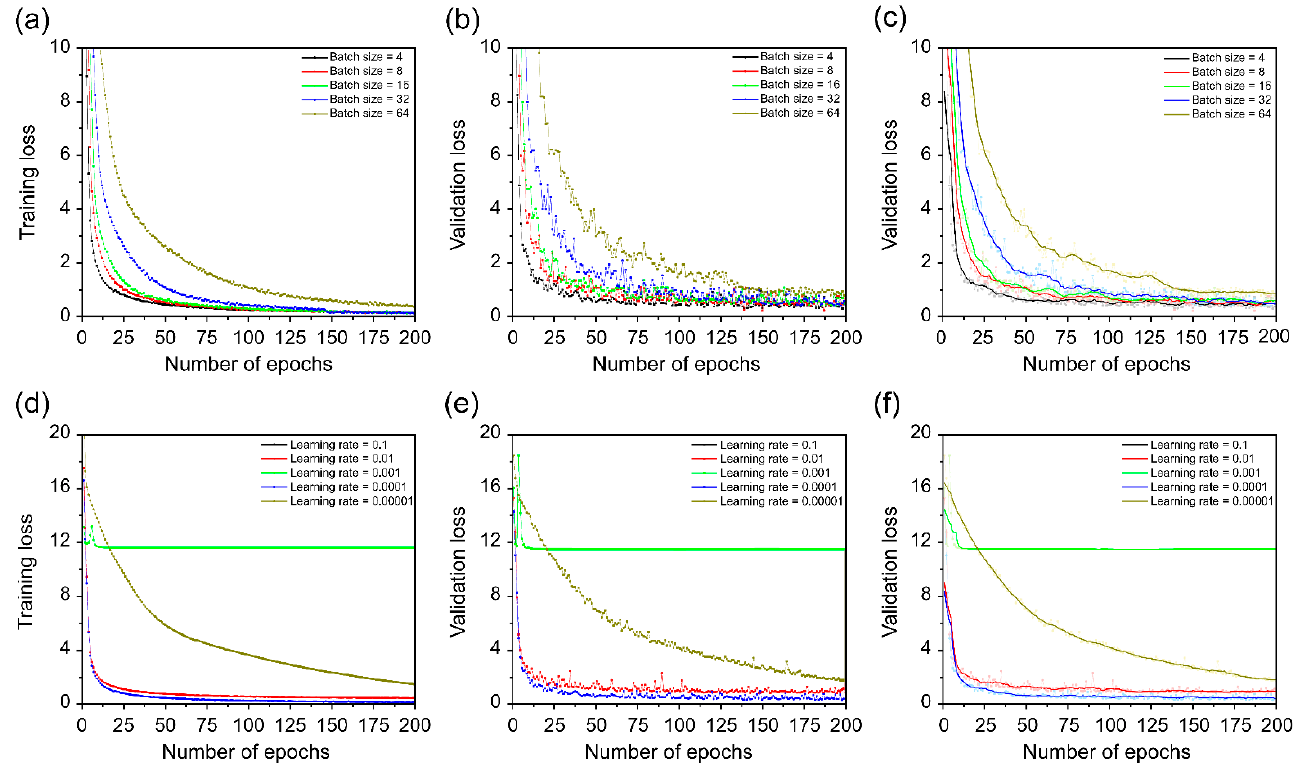
Figure 9. Training and validation loss of the collected dataset. ( a ) Different training batch sizes; ( b ) different validation batch sizes; ( c ) different validation batch sizes using moving average; ( d ) differ- ent training learning rates; ( e ) different validation learning rates; and ( f ) different validation learning rates using moving average.